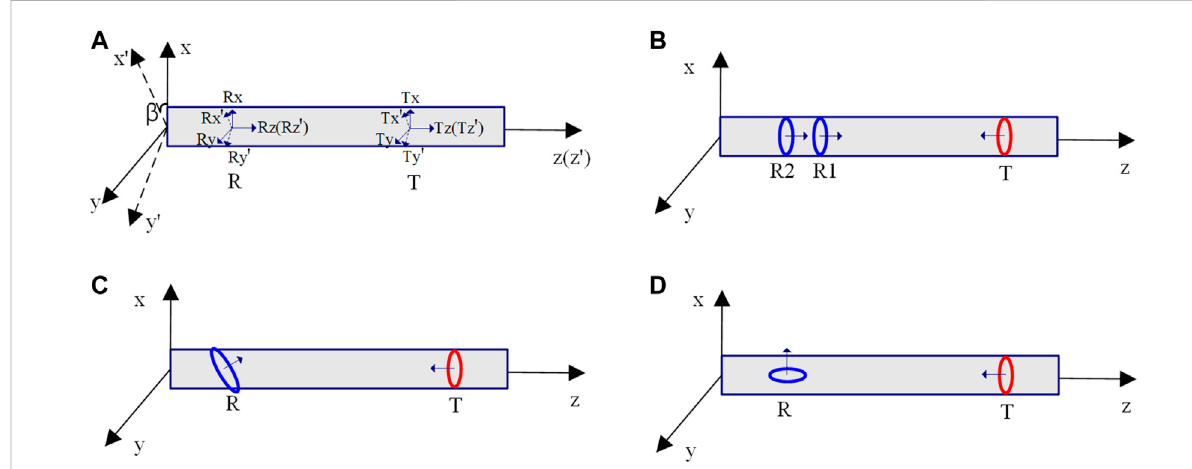
FIGURE 1 Schematic of the electromagnetic wave boundary detection instrument while drilling in the horizontal well.